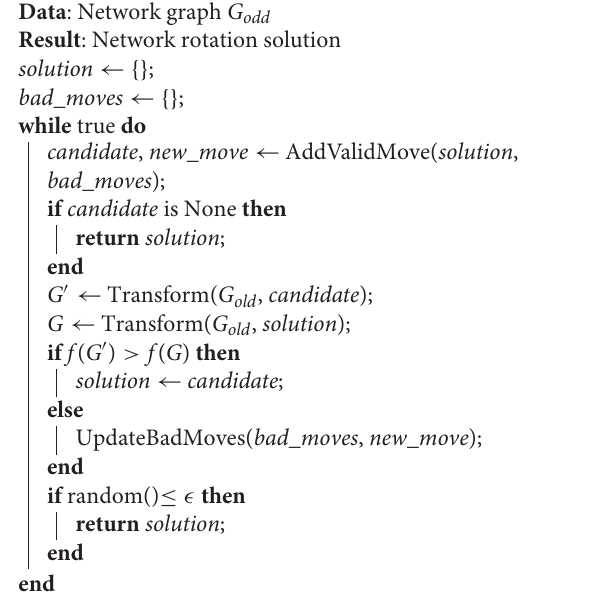
Algorithm 1: Stochastic search algorithm . The algorithm attempts to add as many valid rotations as allowed to the network graph, as long as the new rotation surpasses the current state of the objective function (Equation 7) and until either all moves are exhausted or a local maximum is reached (Salehi and Bernstein,